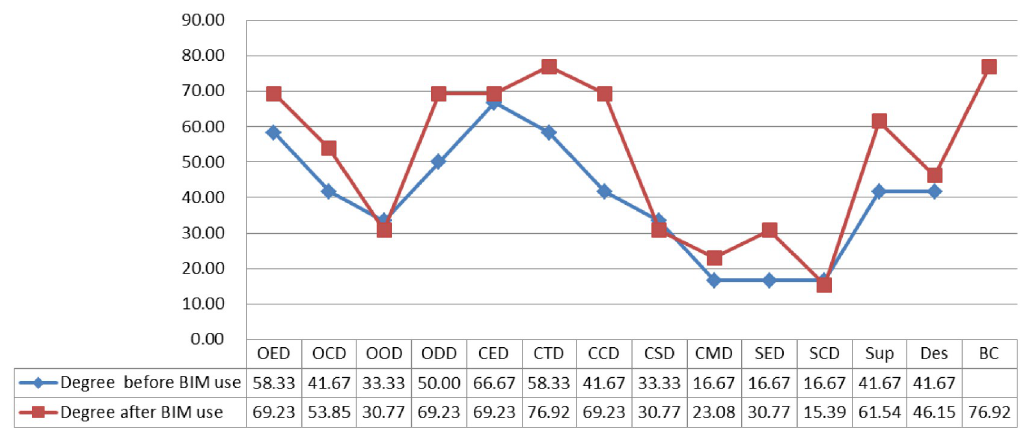
Fig 3. The degree centrality in project communication networks.